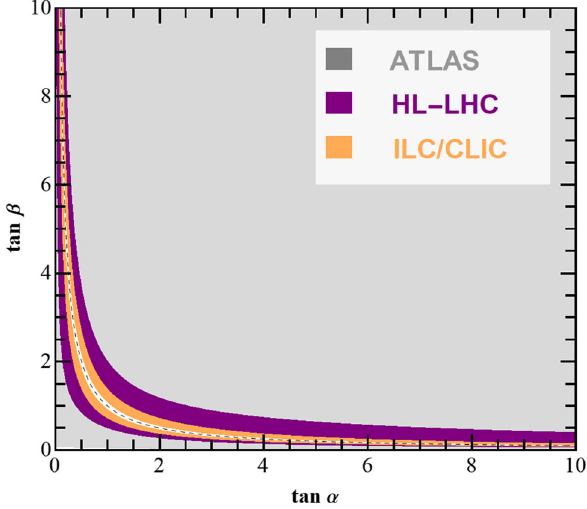
Fig. 4 Exclusion region plot in the ( tan α − tan β) plane obtained from the non-observation of the t → hc flavor violating decay. The gray colored region is excluded by ATLAS data [58], the purple colored regionisexpectedtobeprobedinthefuturebytheHL-LHCexperiment [59] and the orange region will be further probed by ILC or CLIC [60]. The uncolored region (see white thin band) predicts a branching ratio beyond the sensitivity of these experiments. The dashed line indicates limit of no flavor violation in light Higgs Yukawa